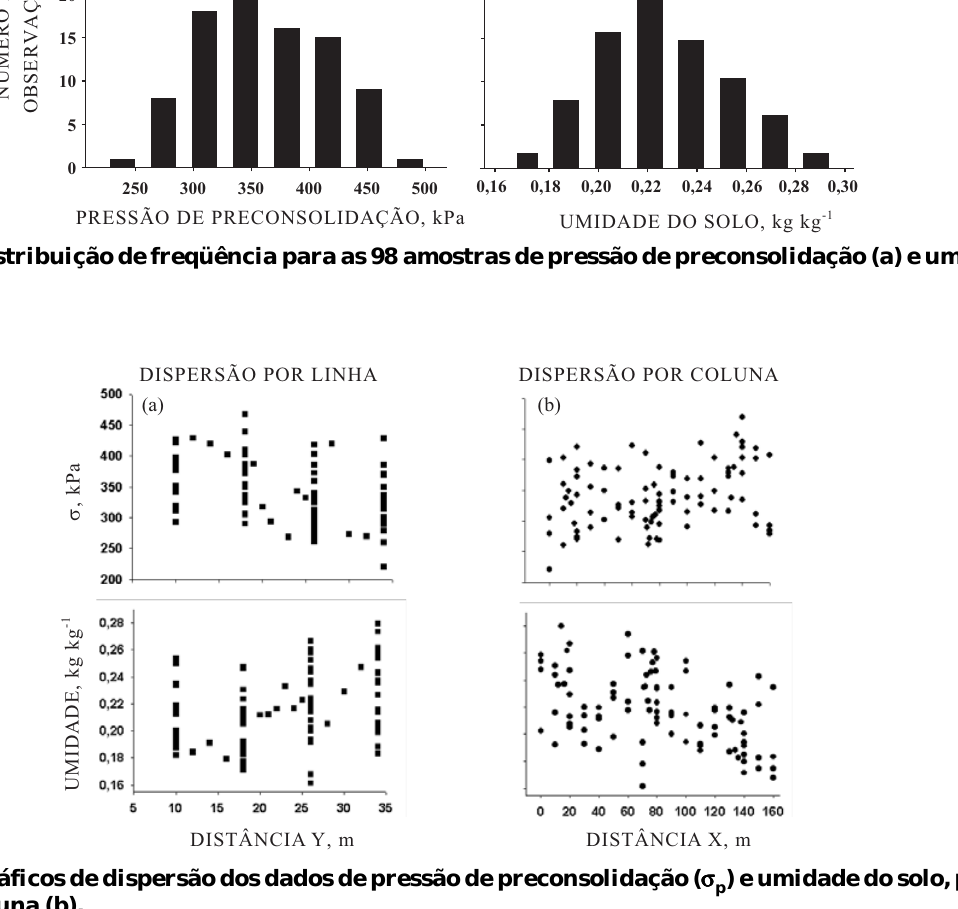
) e umidade do solo, por linha p